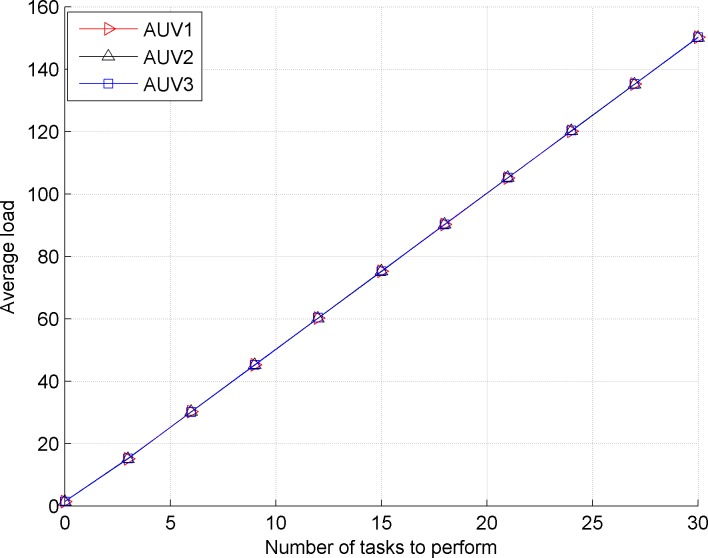
Average load of AUV1, AUV2 and AUV3 in the improved contract net model AUV3.